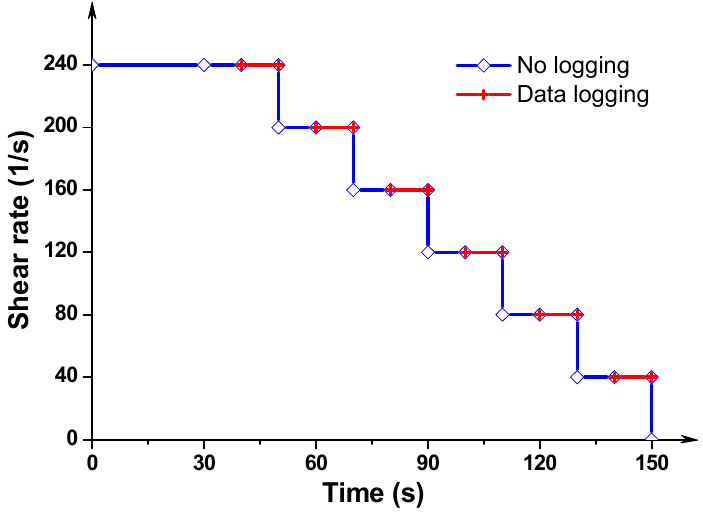
Figure 6. Testing protocol of shear curves.